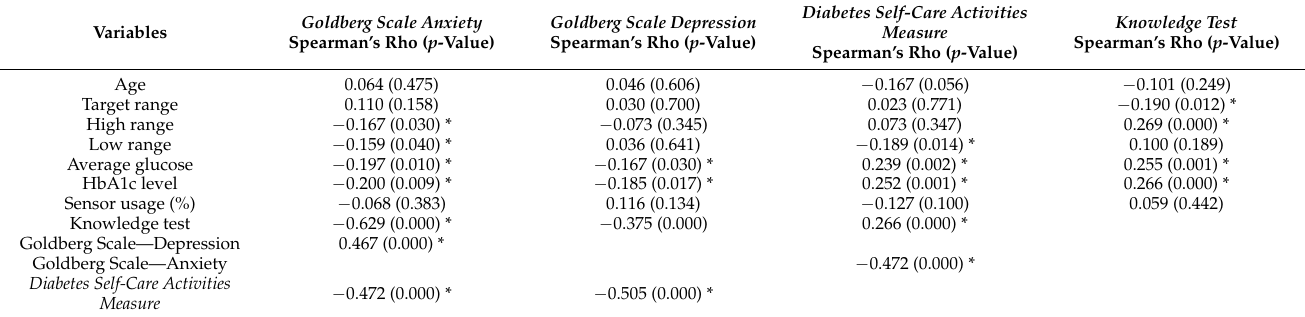
Table 4. Bivariate analysis.